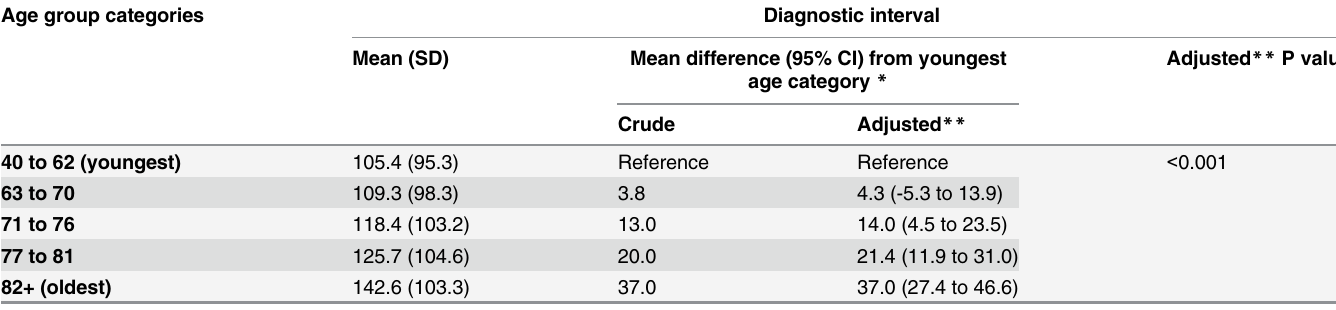
Table 3. Differences in diagnostic intervals across age categories * in colorectal cancer